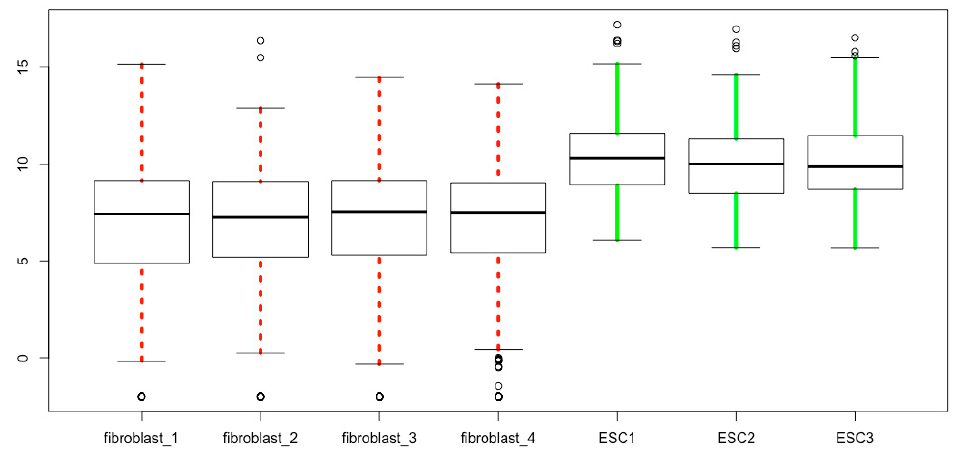
Figure 14. Define the line style, line thickness, and line color of the whisker parts of boxplots.